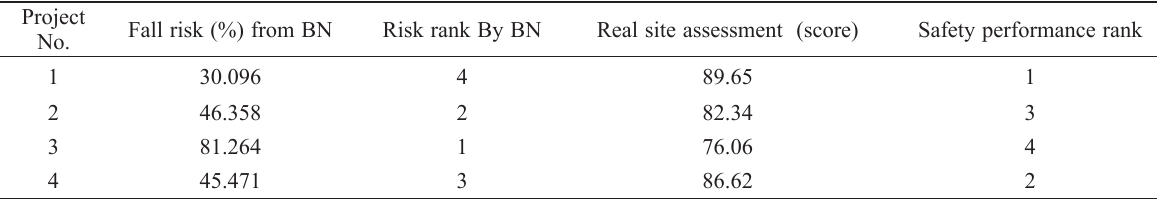
Table 6. Comparison between BN and real site assessment Project